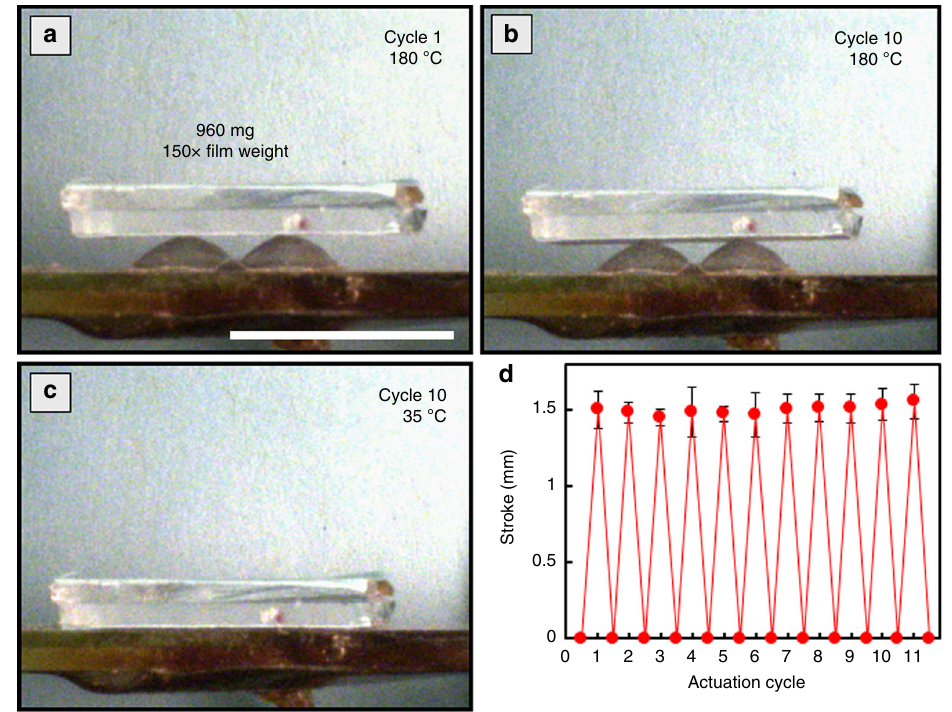
Fig. 3 Actuation cycles. Four layer LCE laminate composed of layers with 2 × 2 array of + 1 defects. Scale bar is 1 cm. Deformation of the four layer LCE laminate under 960 mg load was monitored a after 1 cycle, b 10 cycles (heating step), and c 10 cycles (cooling to 35 °C). d Stroke vs thermal cycle for 11 actuation cycles. Error bar is statistical accuracy of